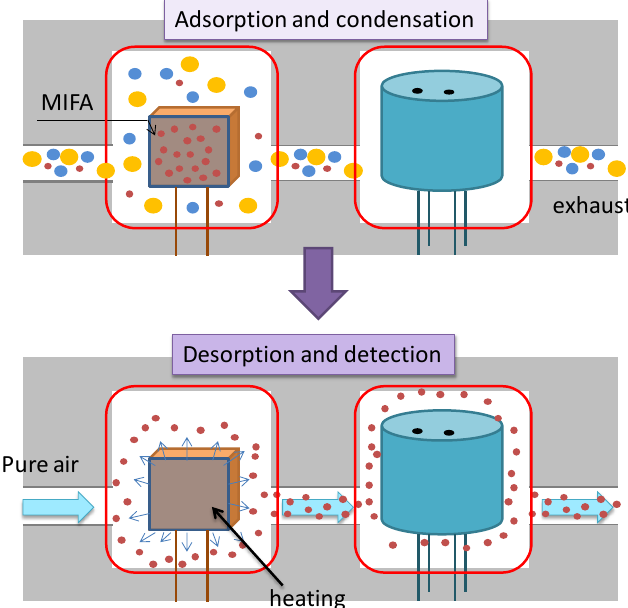
Figure 5. The adsorption and desorption mechanism in the odor-separating